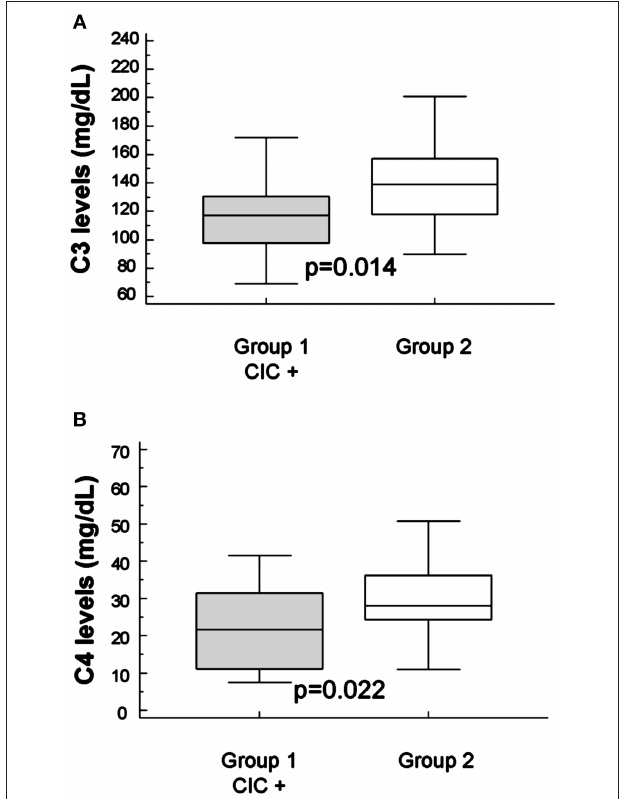
FIGURE 1 | Mean levels of C3 (A) and C4 (B) complement in groups. Mean levels of C3 (115.6 ± 9.2 and 140.9 ± 4.3 mg/dL, group-1 and group-2,